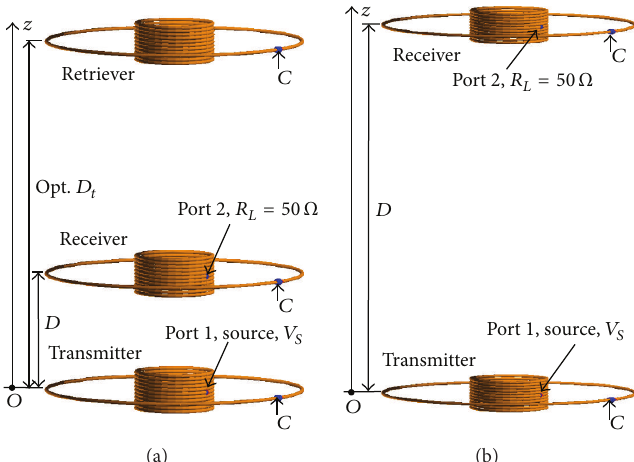
Figure 5: System schematic of retriever-based WPT. (a) WPT system with retriever, that is, retriever-based system. (b) WPT system without a retriever, that is, the classical WPT system.